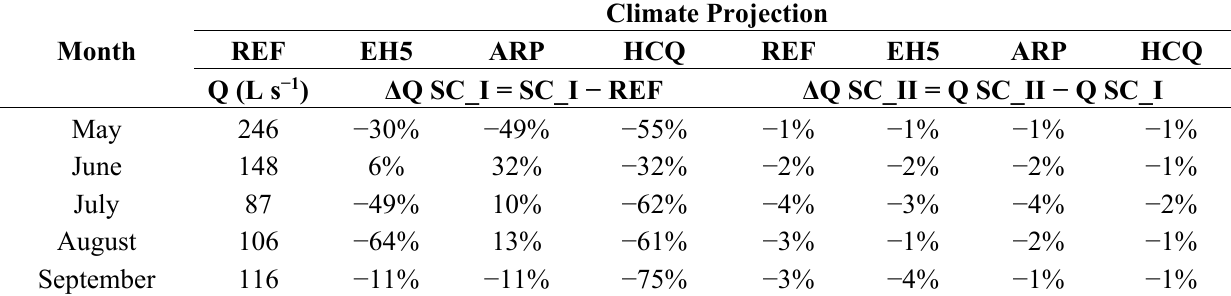
Table 4. Simulated average monthly stream flow rates at the basin catchment outlet in the reference projection (Q) and its projected changes due to climate change ( Δ Q SC_I)